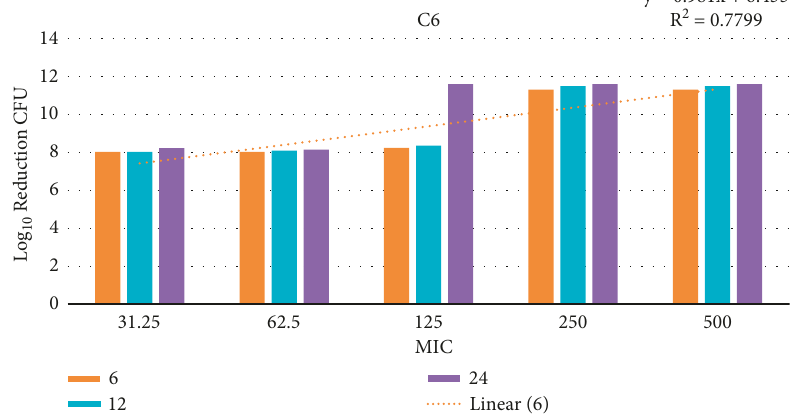
y = 0.981x + 6.435 R 2 = 0.7799